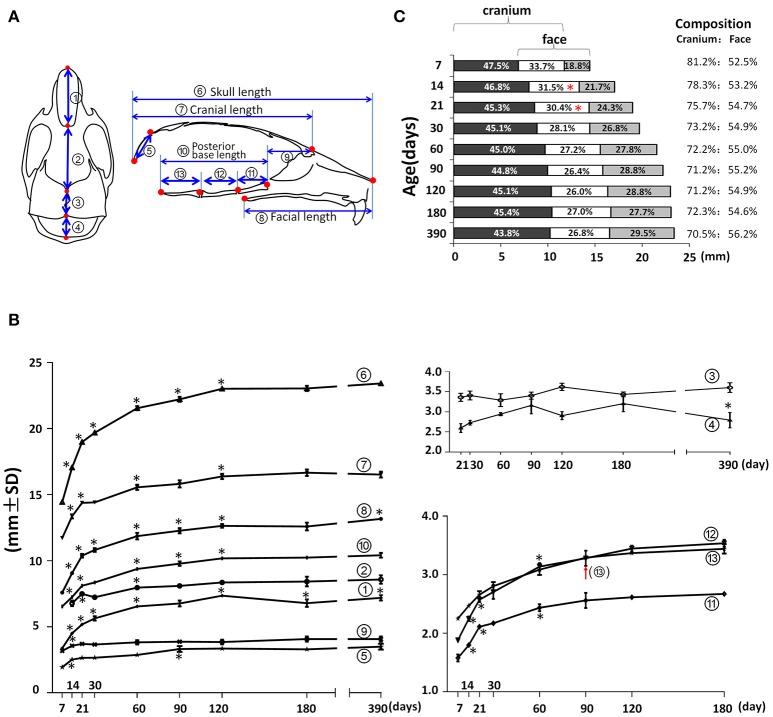
Anterior-posterior (A-P) growth of the mouse craniofacial skeleton. (A) Diagram of mouse skull at ventral view (left) and mid-sagittal plane (right) with landmarks and parameters used for A-P dimension measurements. (B) Growth curves showing dynamic change of individual parameters on A-P dimension with age (landmarks and labels were described in Figure 1 and Table 1). (C) Bar graph showing the growth of the cranial region, facial region, and the overlap region during skull development. Numbers in the bar graph indicate the proportion of each region: cranium exclusive of overlap, overlap, face exclusive of overlap; numbers on the right indicate the proportions of the cranium and face including the overlap. *Represents significant change between indicated data point and immediate earlier time point, and red arrow indicates significant changes between all the neighboring time points before that time point (Tukey's multiple comparison test, p < 0.05).